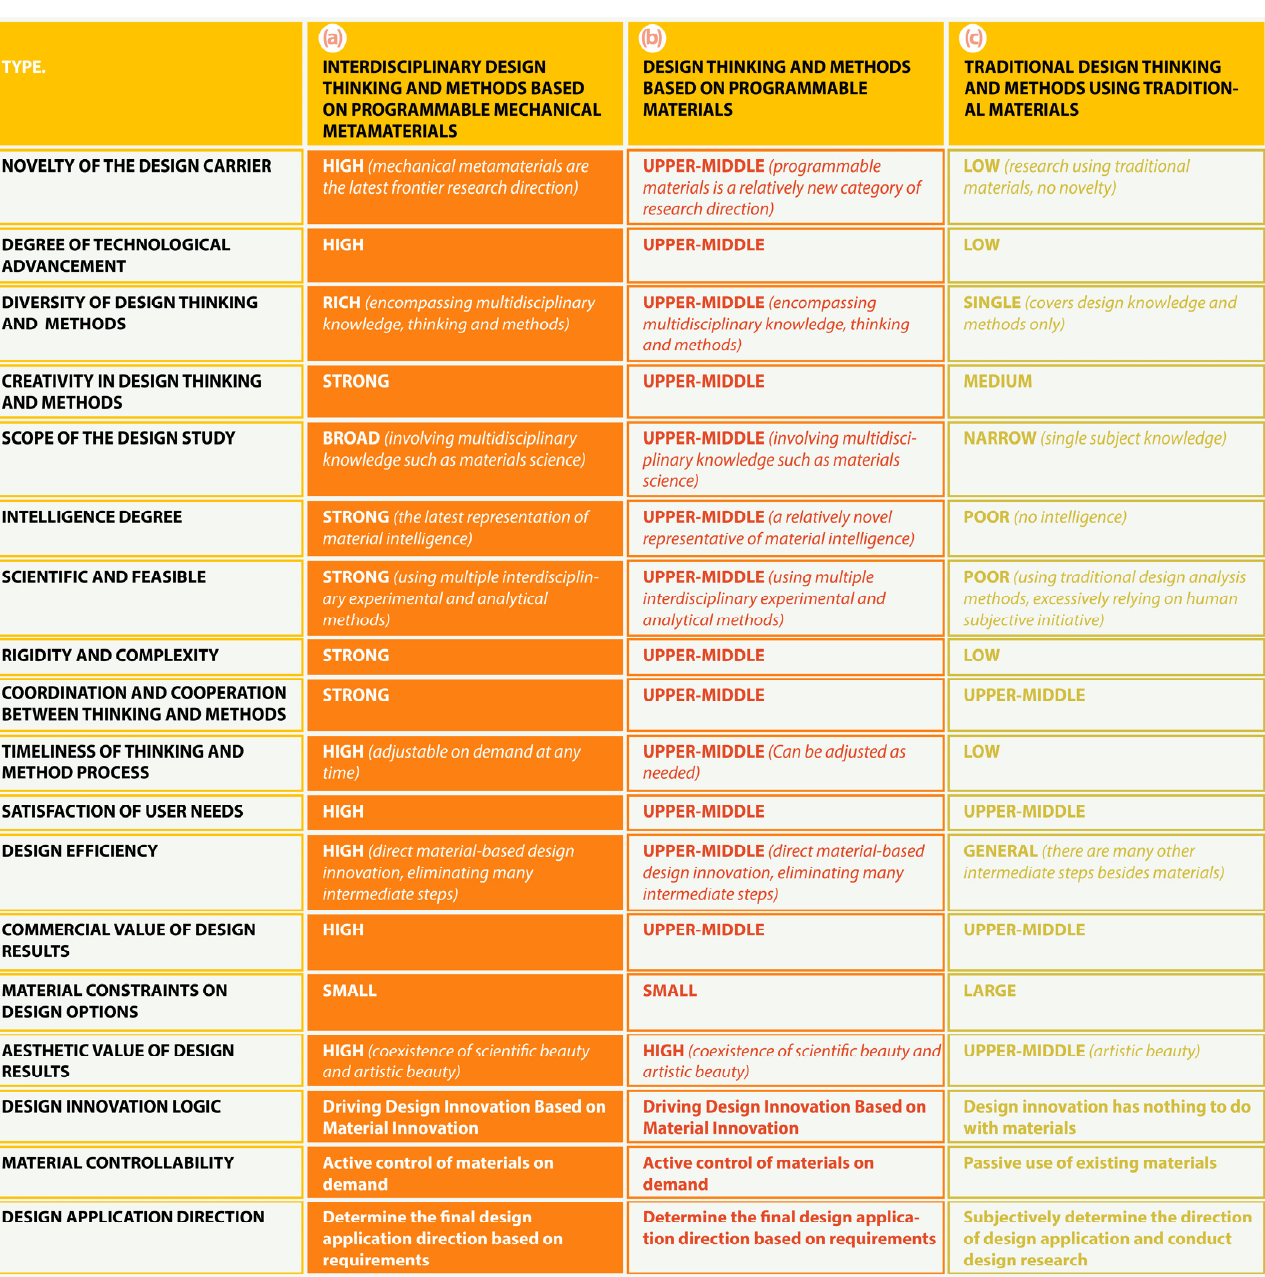
Figure 20. A comparative analysis of the typical characteristics of the three types of design thinking and methods. ( a ) Characteristics of interdisciplinary design thinking and methods based on